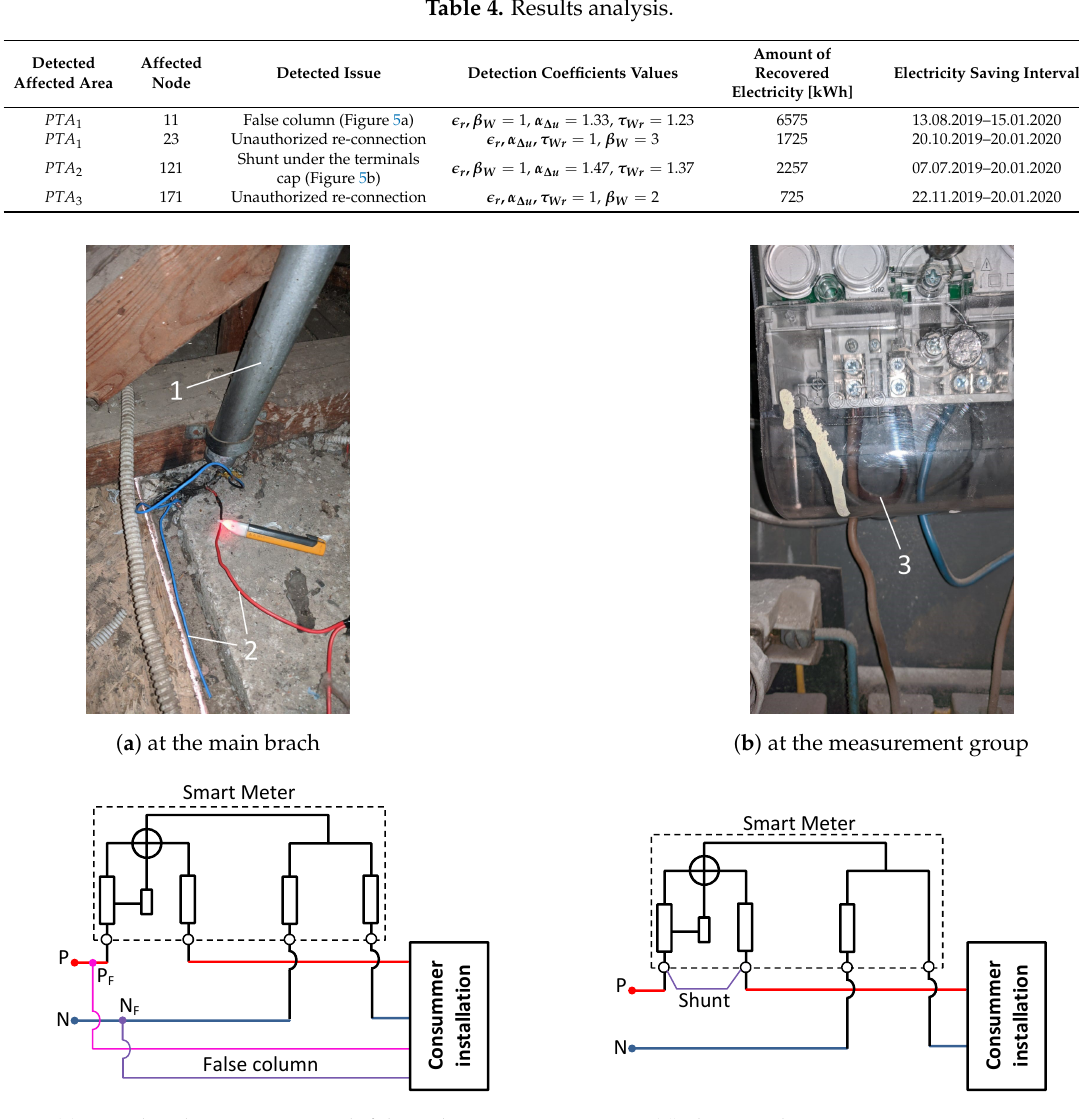
Figure 5. Unauthorised connection and their scheme (1—main branch, 2—false column, 3—shunt connection).